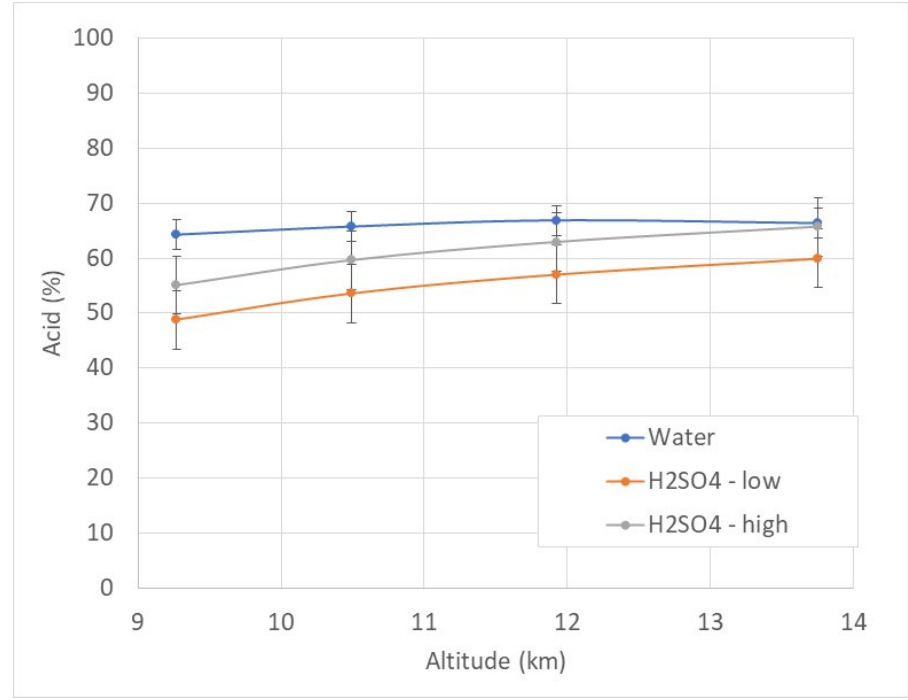
Figure 2. Predicted concentration of sulfuric acid in aerosol droplets as a function of altitude. X axis: altitude (km). Y axis: predicted percentage sulfuric acid in droplets at equilibrium with gas phase water and sulfuric acid at that altitude. Plotted are the predicted concentrations calculated from two sulfuric acid gas phase abundances and the seasonal distribution of water gas phase abundances. Error bars are estimated errors in prediction of H 2 SO 4 concentration from gas phase concentrations, as described in Appendix A. Table 2. Conditions used to model the reaction of compounds to sulfuric acid. Measurements by balloon sonde listed in the Integrated Global Radiosonde Archive (IGRS) database [29] at NOAA (https://www.ncei.noaa.gov/pub/data/igra/ (Accessed on 02 May 2022) are listed for specific pres- sure, not specific altitude; the pressure is listed in column 1, the altitude and temperature ranges over 0–70° Latitude and January–December monthly averages (See Figure 1) are listed in columns 2 and 3, and the range of inferred sulfuric acid concentrations in aerosol droplets (See Figure 1) in column 4.